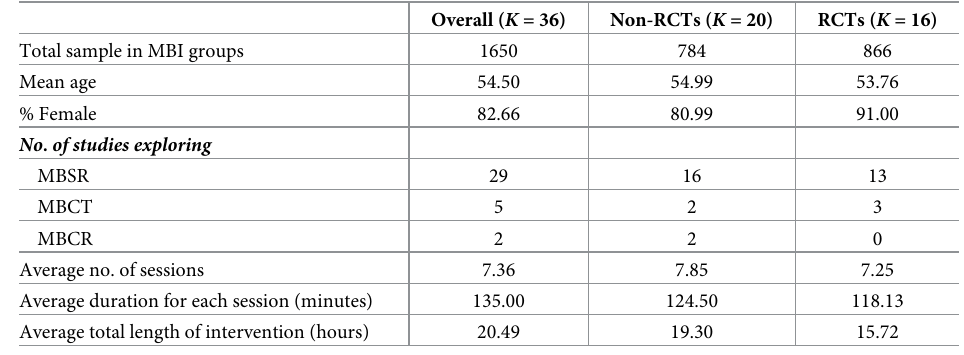
Table 1. Summarized characteristics of the 36 included studies.